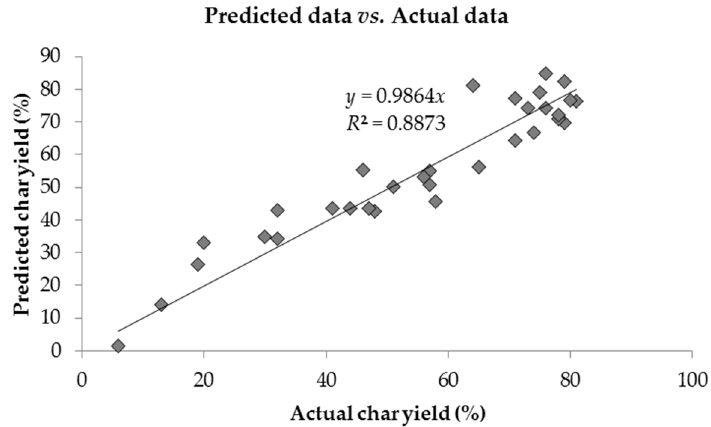
Figure 2. Partial Least Squares (PLS) regression graph of prediction of char yield vs. actual char yield of lowest energy molecular structures.